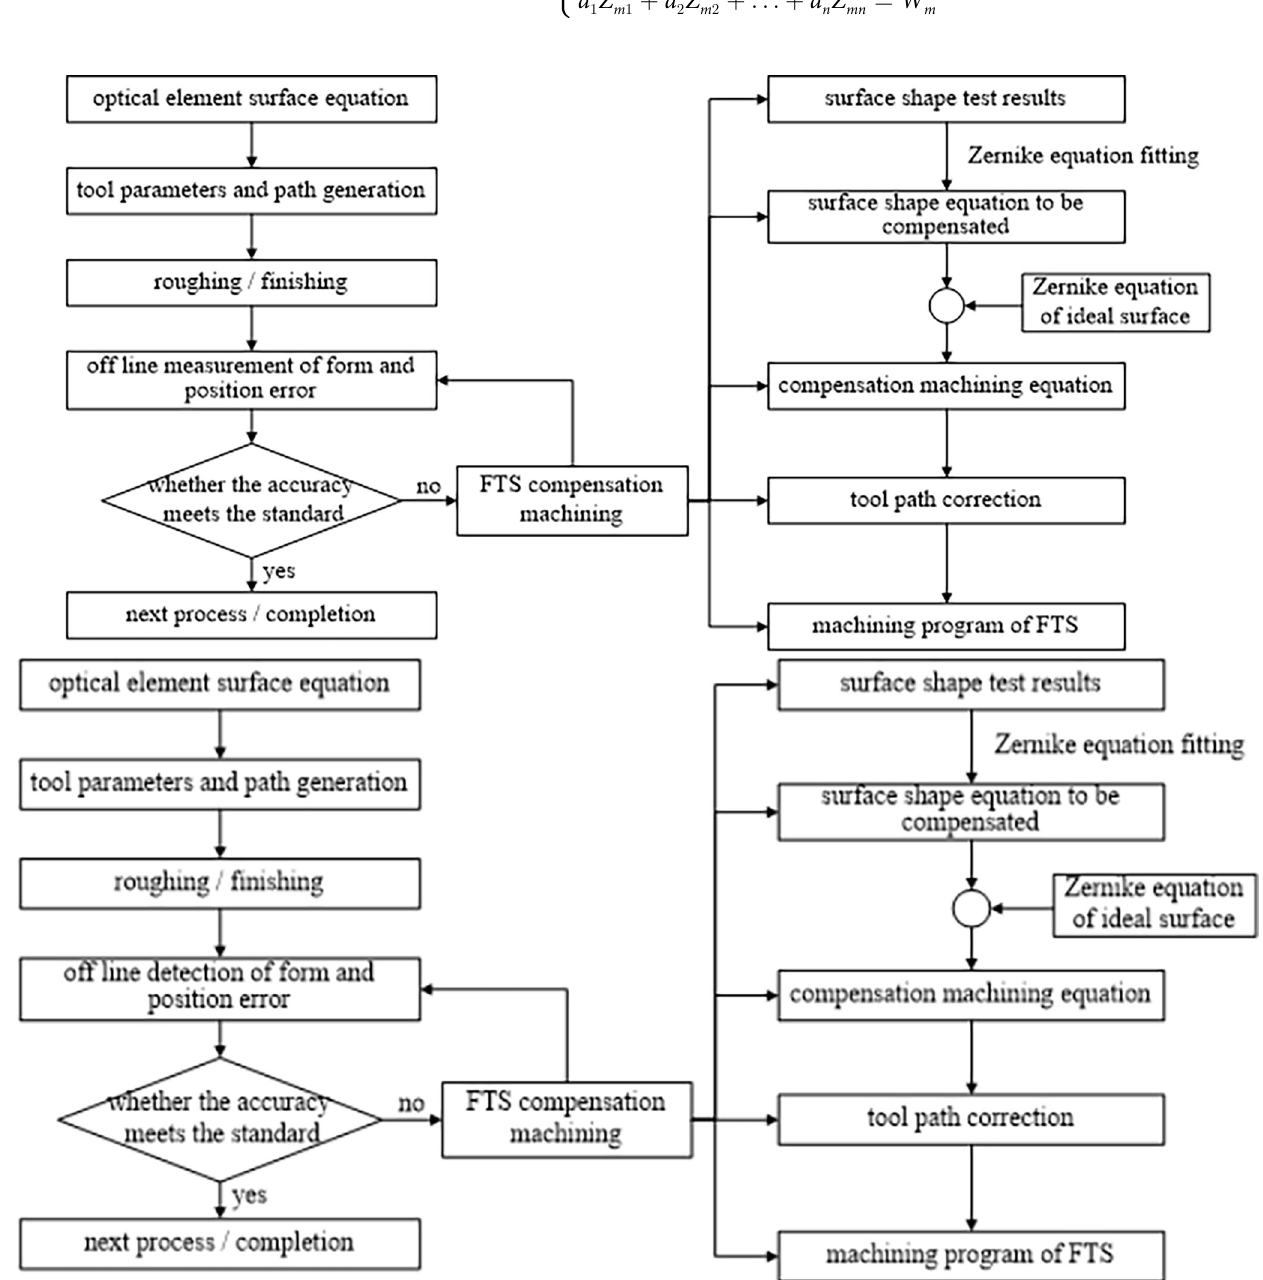
Fig 3. Flow chart of off-line detection and turning error compensation method. https://doi.org/10.1371/journal.pone.0282752.g003 PLOS ONE | https://doi.org/10.1371/journal.pone.0282752 March 16,